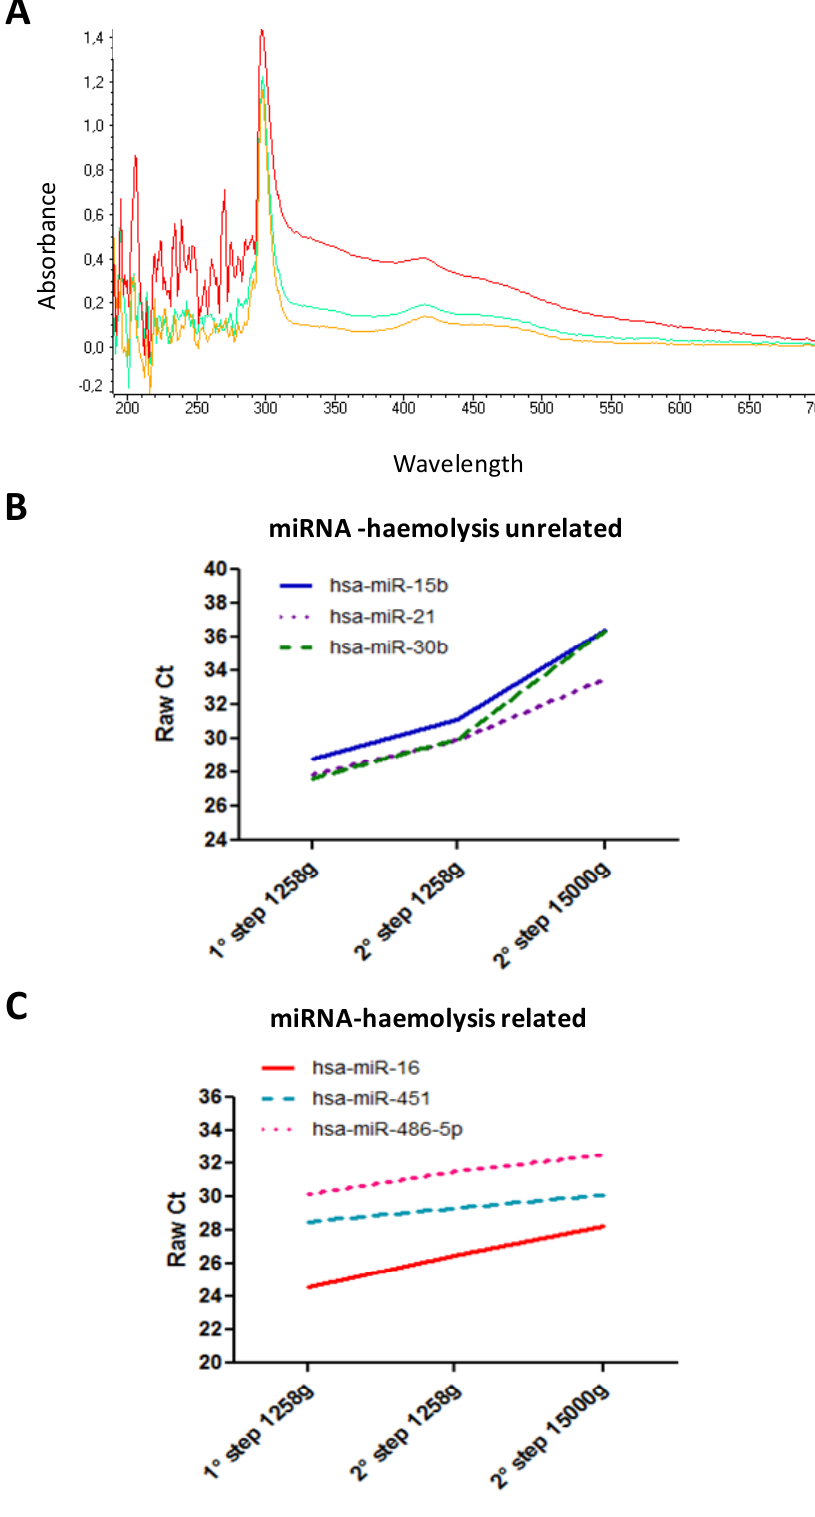
Figure 1. Spectrophotometric and molecular characterization of plasma samples obtained with different protocols of whole blood processing. ( A ) Spectrophotometric profile of samples after the first step of centrifugation at 1,258 g (red line) and after the second step of centrifugation at 1,258 g (blue line) or at 15,000 g (yellow line). ( B ) Expression level (raw Ct data) of haemolysis-unrelated miRNAs and ( C ) of haemolysis-related